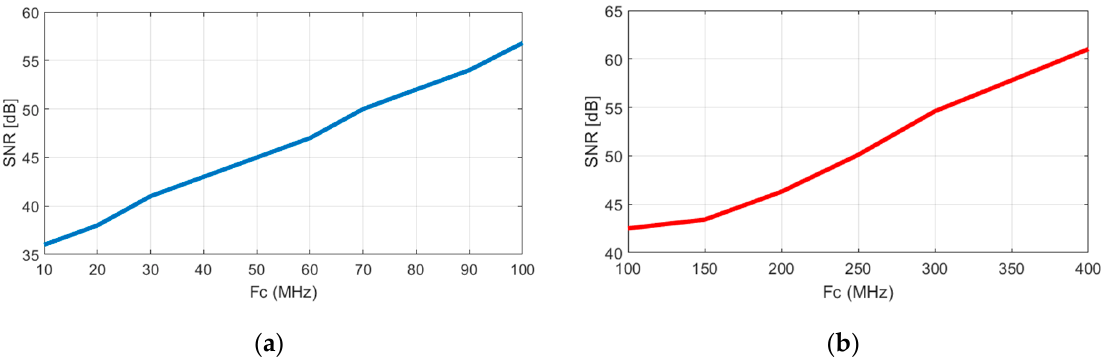
Figure 12. Signal-to-noise ratio (SNR) versus f C : ( a ) f S 1 = 200 MHz and f S2 = 800 MHz; ( b ) f S1 = 400 MHz and f S2 = 1.6 GHz.